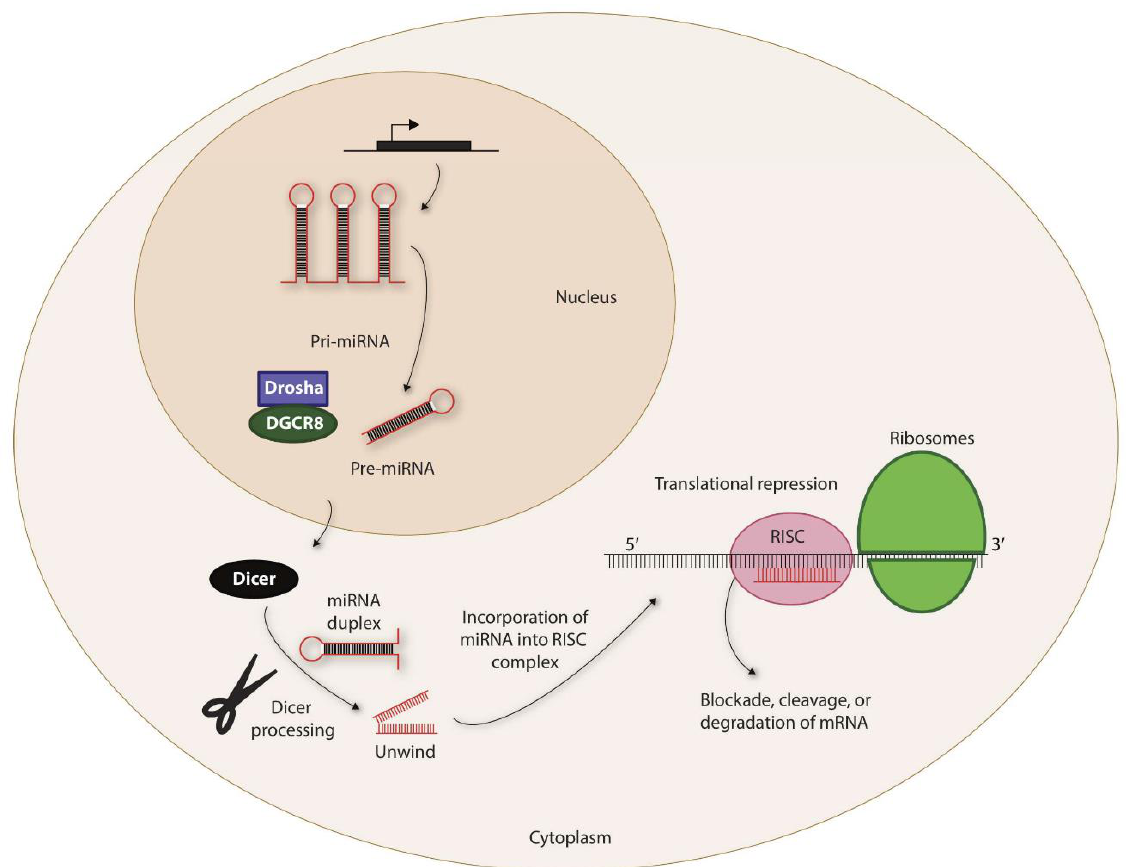
Figure 1. Biogenesis of miRNAs. The non-coding miRNAs are transcribed as Pri-miRNAs. This is processed by a complex containing Drosha and DiGeorge syndrome critical region 8 (DGCR8) within the nucleus to generate precursor-miRNA (Pre-miRNA). Pre-miRNAs are exported to the cytoplasm via exportin-5 that is located in the nuclear membrane. The 7- methylguanine-capped (m 7 G) pre-miRNAs depend on Dicer to complete their cytoplasmic maturation. The miRNA-induced silencing complex (RISC) recruits miRNA and the target transcripts to induce specific translational repression.